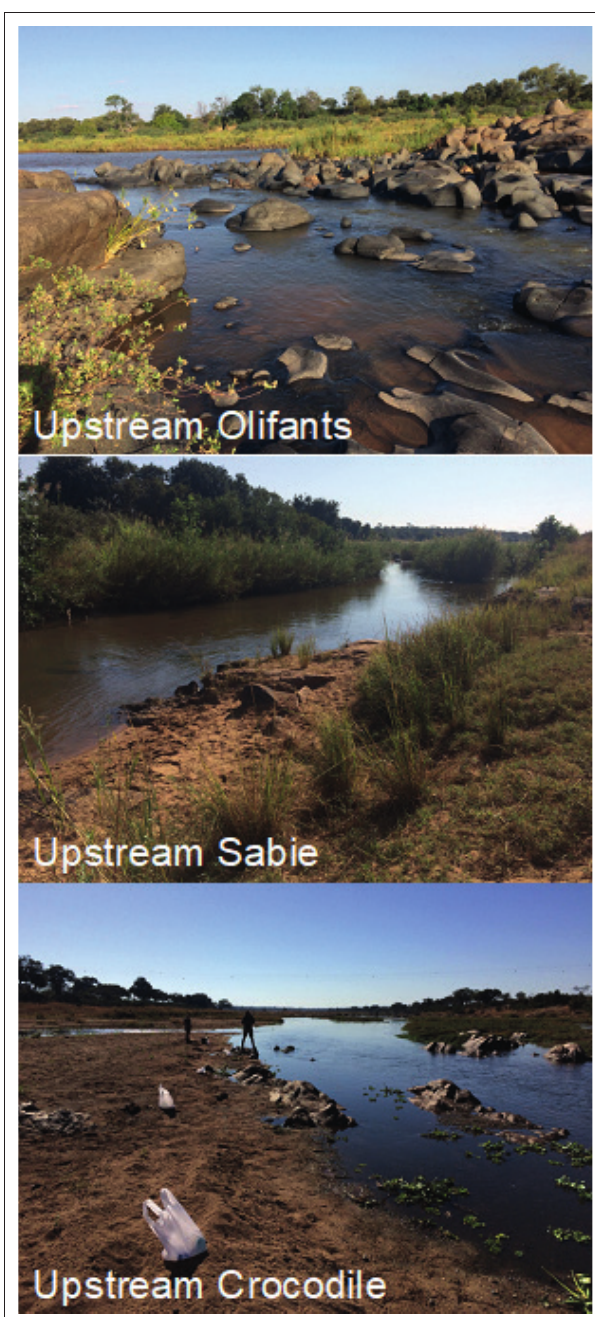
FIGURE 2-A1: Upstream sampling sites and surrounding